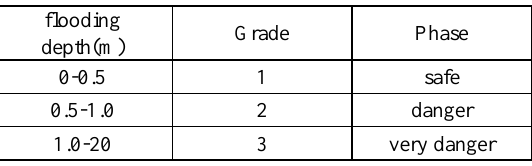
Figure 3. River and Inland Flood Mixing Zone Table 2 show the river and inland flood hazard risk weight.